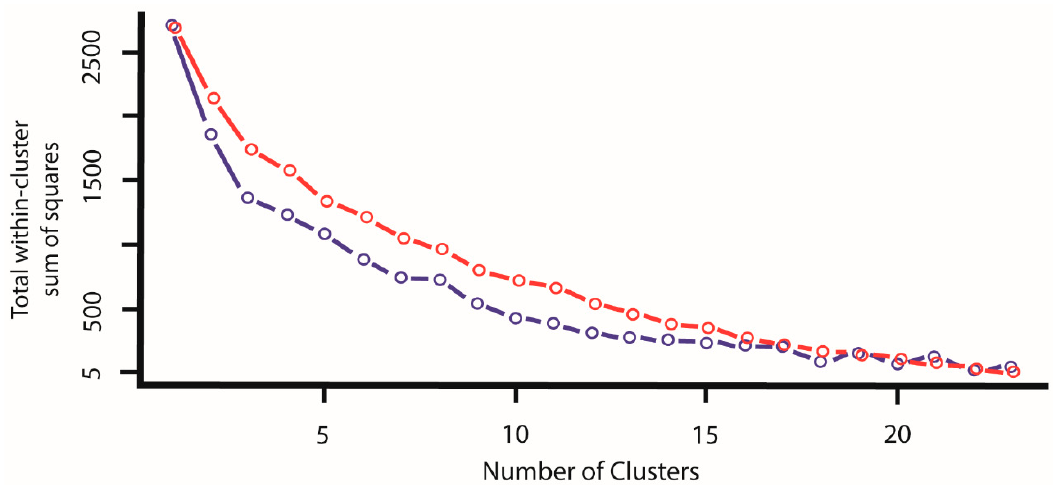
Figure 6. K-means sedimentation graphs of cluster sub-periods. Blue dots represent the first sub-period (from October 1975 to September 1995) and red dots the second sub-period (from October 1995 to September 2016).